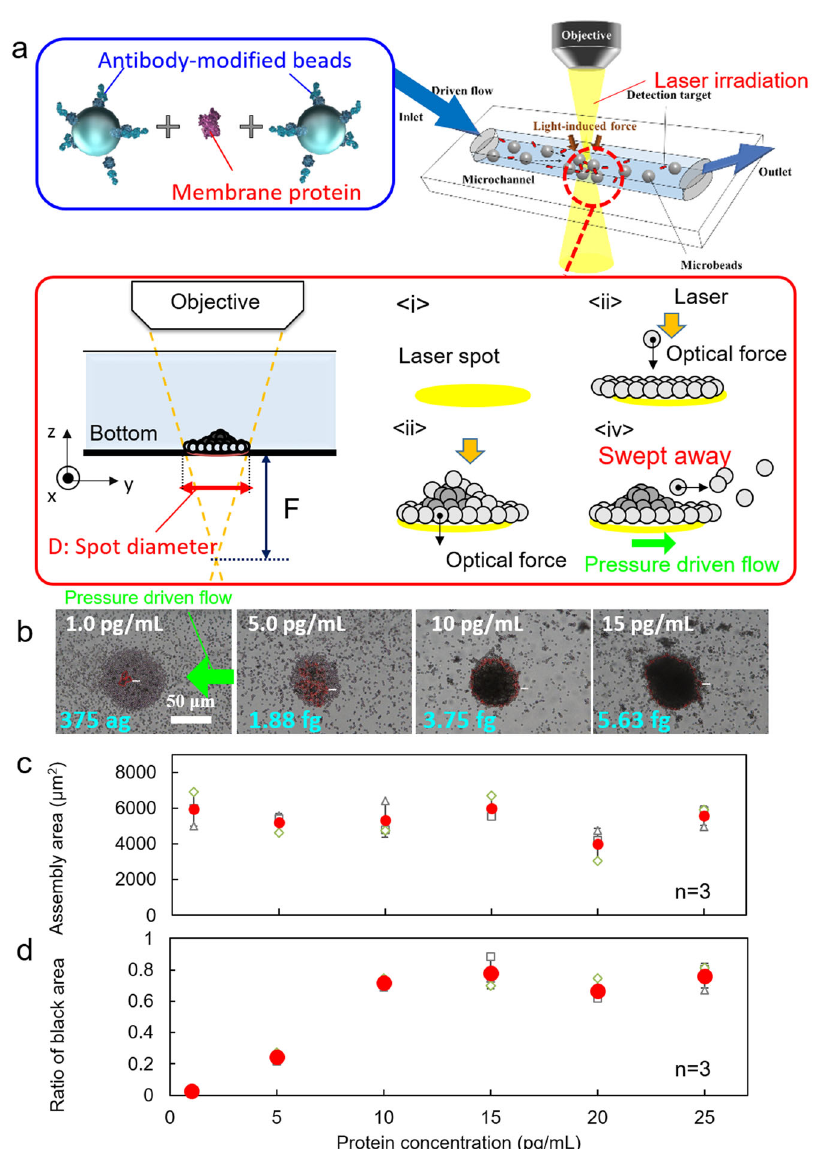
Fig. 2 Top-down light-induced acceleration of antigen – antibody reactions with a membrane protein. a Schematic diagram of the process of forming a three-dimensional structure by an antigen – antibody reaction with a defocused laser spot diameter. b Optical transmission image of the assembled structure of CD80 as the target and probe beads modi fi ed with anti-CD80 antibody. The pressure-driven fl ow is in + y -direction, which appears to be inverted in the microscope transmission image. Protein concentration dependence of c , total assembly area of the complex of CD80 and probe beads, and d ratio of the black area (multi-layered part). In c and d , error bars indicate standard deviation. Individual data points are shown as small